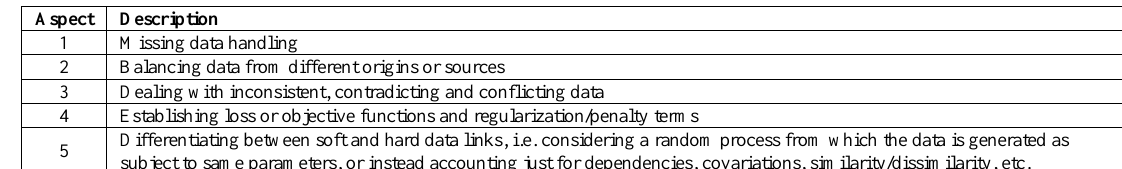
Table 3. Critical aspects in data